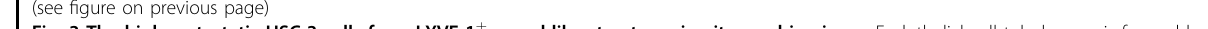
Fig. 3 The high-metastatic HSC-3 cells form LYVE-1 + vessel-like structures in vitro and in vivo. a Endothelial cell tubulogenesis formed by Matrigel-seeded human umbilical vein endothelial cells (HUVEC). b Matrigel-seeded HSC-3 cells formed well-de fi ned, interconnected, vessel-like network that resembled the structures formed by HUVEC. c On contrary, the low-metastatic SCC-25 cells remained as single cells and failed to form any consistent vessel-like structures on Matrigel. Scale bar 100 µm. In brief, HUVEC and OSCC cells were fi rst suspended in serum-free medium and seeded at a density of 20 × 10 3 cells/well in 96-well plates pre-coated with 9.375 mg/ml Matrigel ® basement membrane matrix (Corning, New York, USA). Cells were then incubated for 24 h at + 37 °C. d The HSC-3-formed vessel-like cell networks were strongly LYVE-1 + particularly at the tubular extensions and intercellular junctions. Scale bar 100 µm. Matrigel-seeded cells were fi rst fi xed in 4% paraformaldehyde (Santa Cruz) for 20 min at RT and washed once in PBS. Next, samples were incubated in normal serum for 1 h at RT, and the staining continued as aforementioned above. e The xenograft mice model of OSCC revealed formation of CK + /LYVE-1 + vessel-like structures by HSC-3 cells in the harvested tumour sections. Scale bar 50 µm. Human HSC-3 cells were detached, suspended in cold serum-free DMEM and then mixed with a cold Matrigel at 1:1 to a fi nal concentration of 8 × 10 6 cells/ml. BALB/c nude male mice (Charles River, Germany) were anaesthetised at age of 7 weeks via subcutaneously administered mixture of 0.5 mg ketamine and 0.1 mg xylazine hydrochloride. More details are described in the supplementary materials. Sections from 18 mice comprised primary ( n = 9) and metastatic ( n = 9) tumours were used for double-label IF staining as described before. The investigators were blinded to the animal group allocation during the experiment and when assessing the outcome by using samples with coded labels with no reference to any respective group. The experiments followed the ARRIVE guidelines and were conducted in accordance with the European Convention for the Protection of Vertebrate Animals for Experimental and Other Scienti fi c Purposes´ guidelines on accommodation and care of animals. Cell culture imaging was performed using a Zeiss digital AxioCam ERc5s camera connected to Zeiss Axioplan microscope (Carl Zeiss Microscopy GmbH, Jena, Germany).